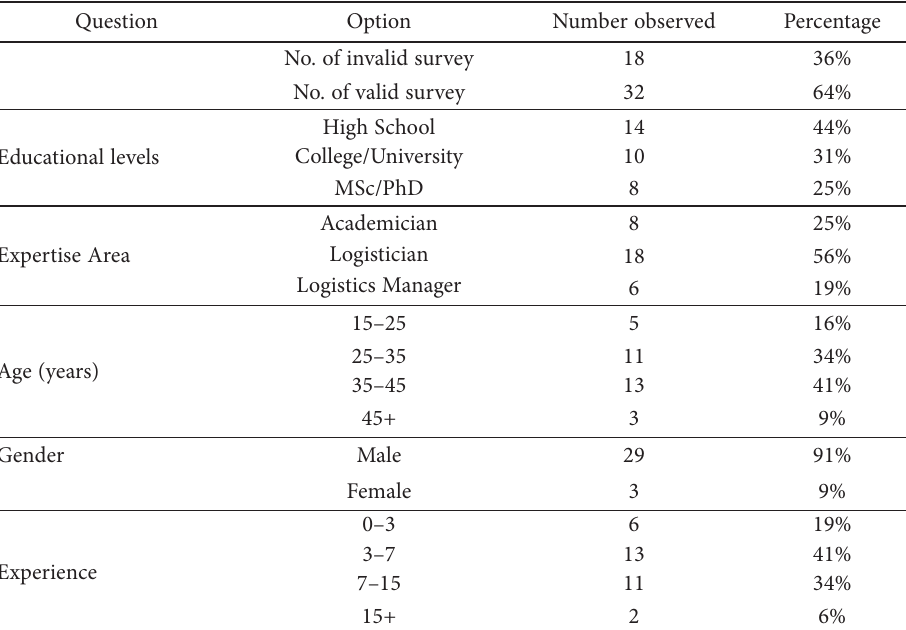
Table 3. The demographic information of